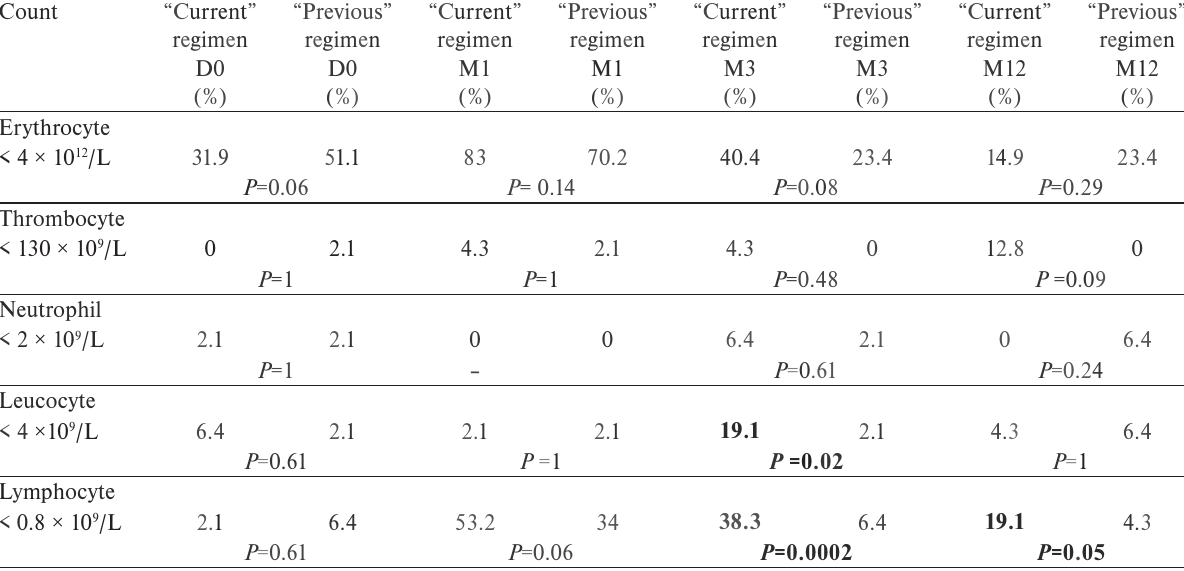
Table 2. Percentage of patients who developed significant bone marrow suppression during follow up.